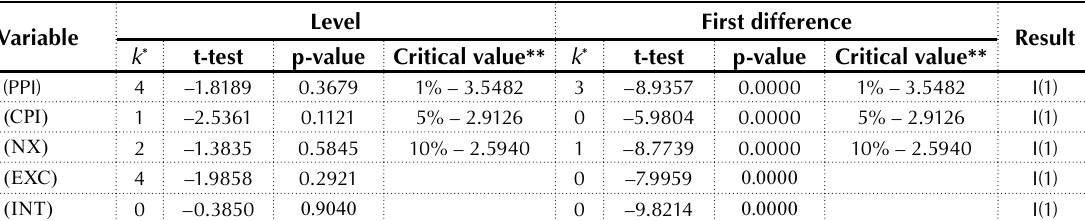
Table 2. Unit root test results